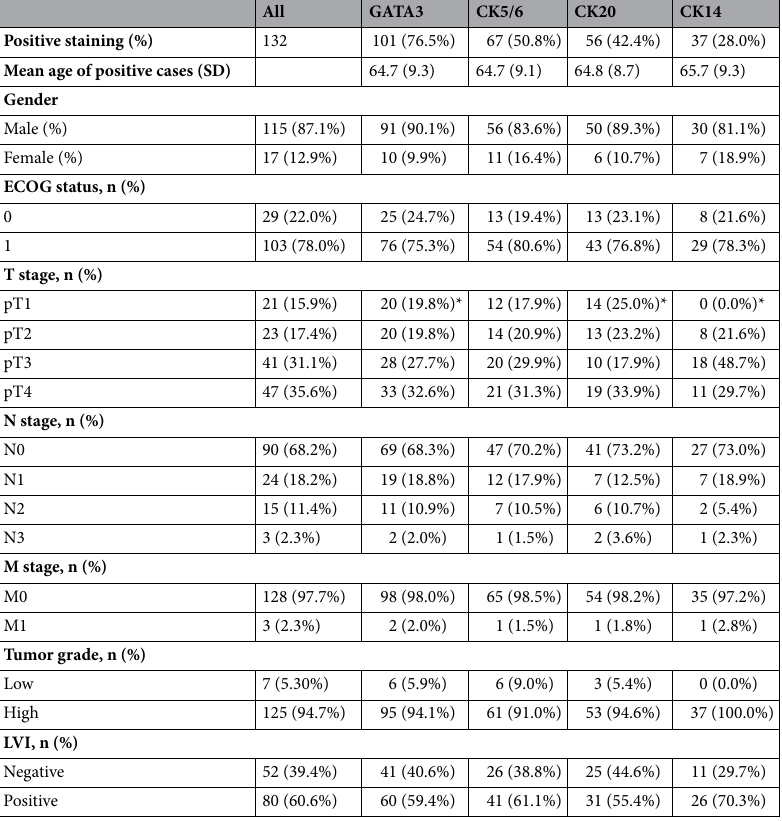
Table 2. Immunopositivity of the four markers analyzed and their correlation with clinicopathological parameters. * p value < 0.05 when distribution between positive cases and among all cases was compared; LVI: lymphovascular invasion.